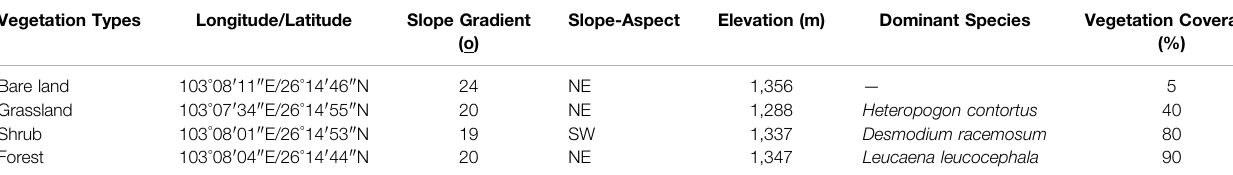
TABLE 1 | Experimental conditions of four vegetation types. Vegetation Types